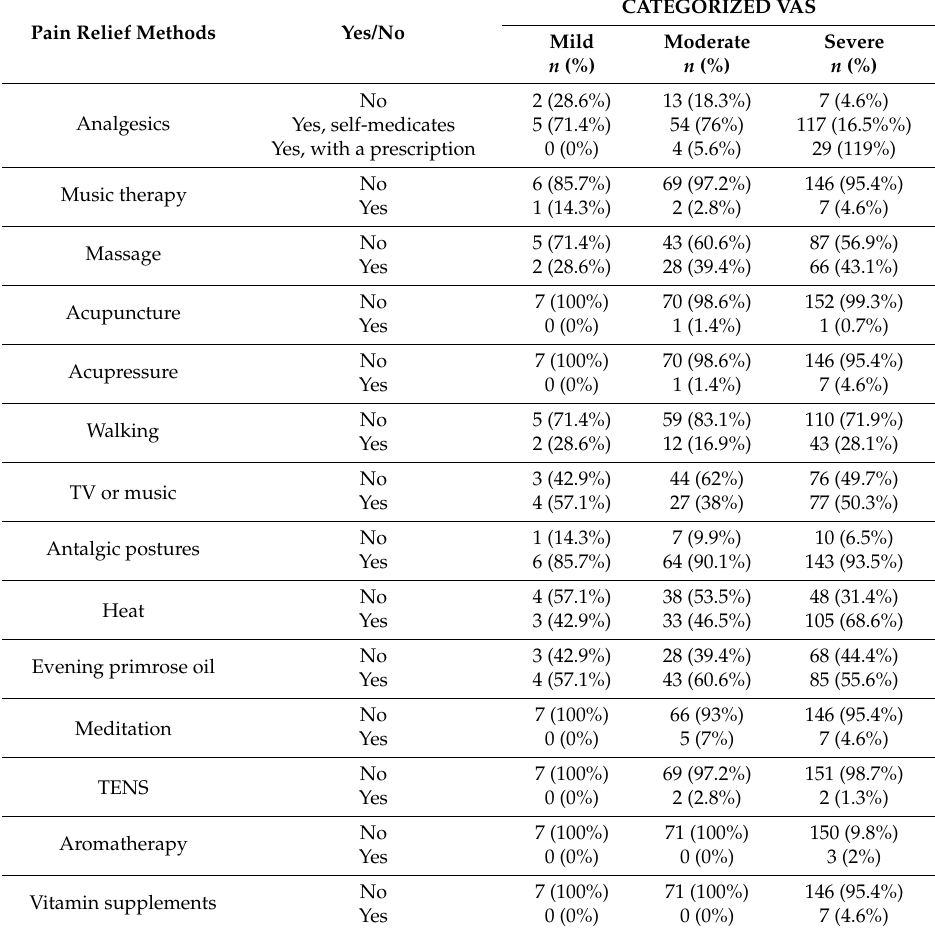
Table 5. Use of pain relief methods in women categorized by their pain intensity in relation to